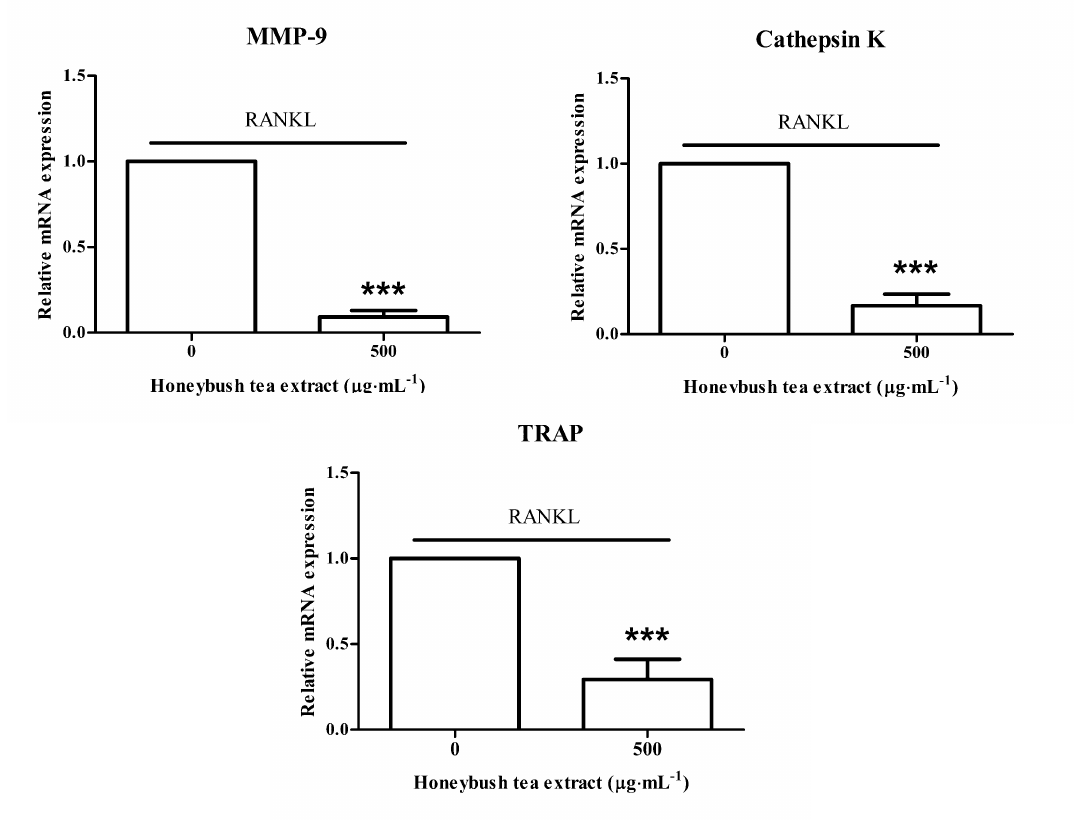
Figure 5. Effect of honeybush tea extract on osteoclast specific gene expression. Cells were exposed to RANKL (15 ng  mL −1 ) alone or in combination with honeybush tea extract at 500 µg  mL −1 for 5 days. Gene expression of osteoclastic markers, MMP-9, TRAP and cathepsin K, was determined by qRT-PCR. GAPDH served as the loading control. Data are mean ±SD and are representative of three independent experiments conducted in triplicate. * p < 0.05; ** p < 0.01; *** p < 0.001 vs.